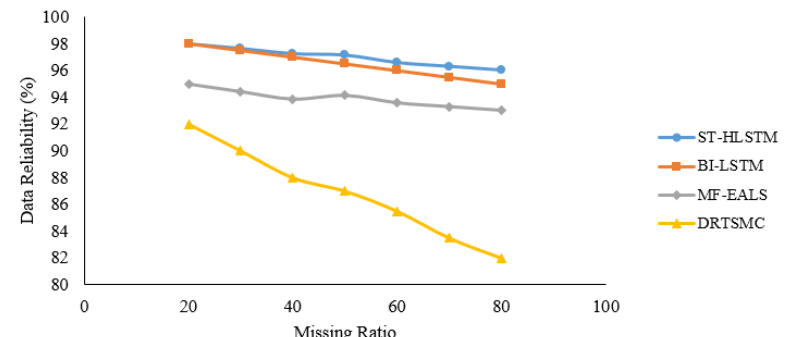
Figure 6. Reliability of